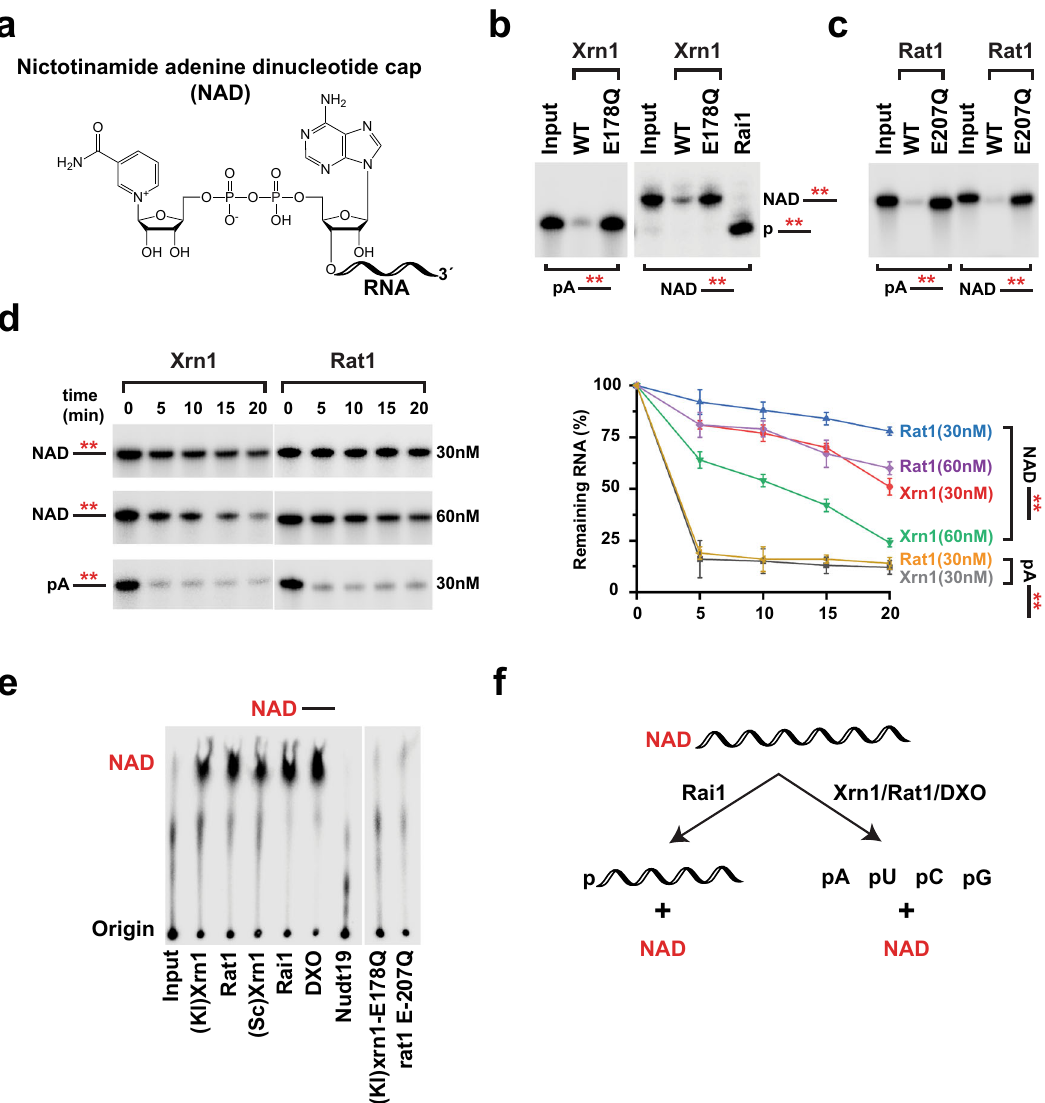
Fig. 2 Xrn1 and Rat1 are deNADding enzymes. a Structure of NAD-capped RNA. b Reaction products of in vitro deNADding assays with 30 nM recombinant Xrn1, WT, and catalytically inactive ( E178Q ) from K. lactis or 25 nM Rai1 ( S. pombe) , ( c ) and 50 nM recombinant Rat1, WT or catalytically inactive ( E207Q ) from S. pombe . Uniformly 32 P-labeled monophosphate (pA----) or NAD-capped RNA (NAD---) were used as indicated and the line denotes the RNA. The red asterisk represents the 32 P-labeling within the body of the RNA. Reaction products were resolved on 15% 7 M urea PAGE gels with ( b ) and without ( c ) 0.3% 3-acrylamidophenylboronic acid. d Time-course decay analysis of uniformly 32 P-labeled monophosphate or NAD-capped RNA (9pmol) with the indicated amount of Xrn1 or Rat1 (~0.45 or ~0.9 pmol, respectively) protein are shown. Quantitation of RNA remaining is plotted from n = 3 independent experiments with ±SD denoted by error bars. Source data are provided in Source Data File. e NAD-capped RNA containing the 32 P-labeling within the α phosphate of the NAD (represented in red) was subjected to the indicated proteins. Decay products were resolved by polyethyleneimine (PEI)-cellulose thin layer chromatography (TLC) developed in 0.45 M (NH 4 ) 2 SO 4 . Rai1 and DXO served as positive controls, whereas Nudt19 was a negative control. f Schematic of NAD-capped RNA hydrolysis by Rai1, Xrn1, Rat1 and